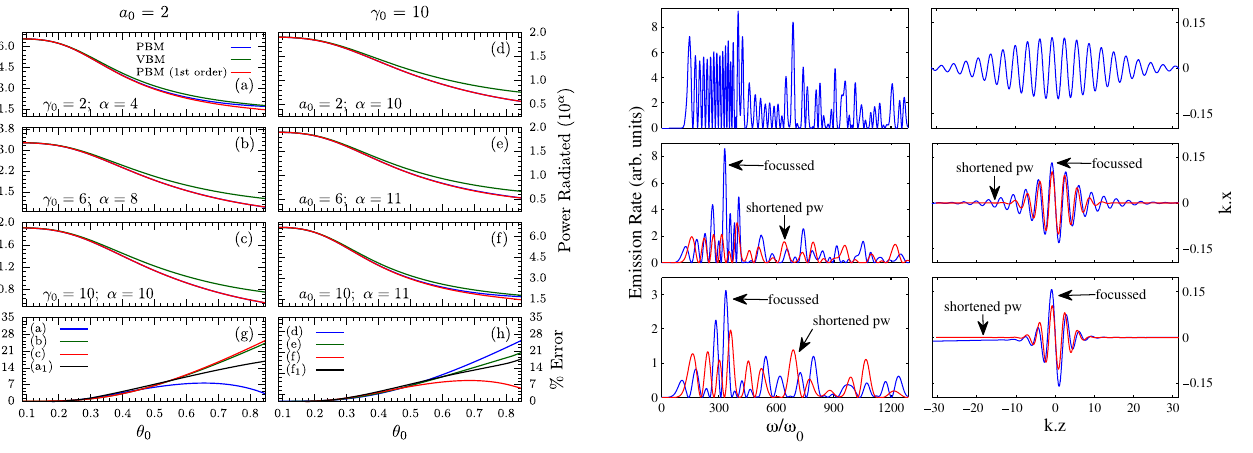
FIG. 12. Spectra and trajectories for an electron of initial γ 10 colliding with a laser of peak a 2 , duration 10 cycles 0 ¼ 0 ¼ (27 fs) and wavelength λ ¼ 0 . 8 μ m, for different levels of focusing. Left panels show emission spectra, right panels show the trajectories. Top row (blue lines): plane wave. Middle row (blue lines): vector beam focussed to θ 0 ¼ 0 . 8 ( w 0 ¼ 0 . 318 μ m). Bottom row (blue lines): vector beam focussed to θ 0 ¼ 1 . 2 ( w 0 ¼ 0 . 212 μ m). The red lines show the same but are calculated using a plane wave with duration shortened to match the actual FWHM duration of the focussed field (which becomes shortened by the focusing). For the middle panels this duration is 3.5 cycles, and for the bottom panels 2.5